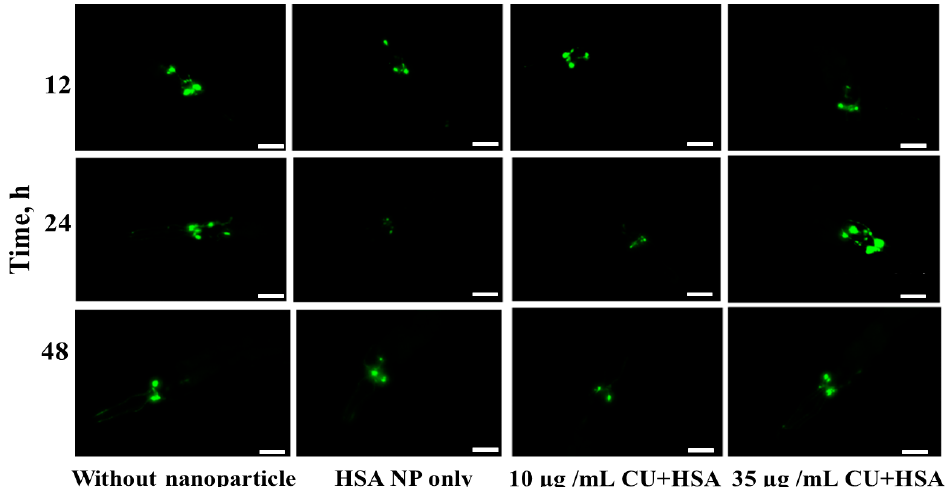
Figure 4. Protection of DA neurons against neurodegeneration. Fluorescence images of anterior DA neurons of BZ555 [dat-1::gfp] C. elegans strain fed with and without CU-loaded HSA nanoparticles (CUHNP) at 12 h, 24 h, and 48 h of adulthood, respectively. Scale bar: 50 µm.